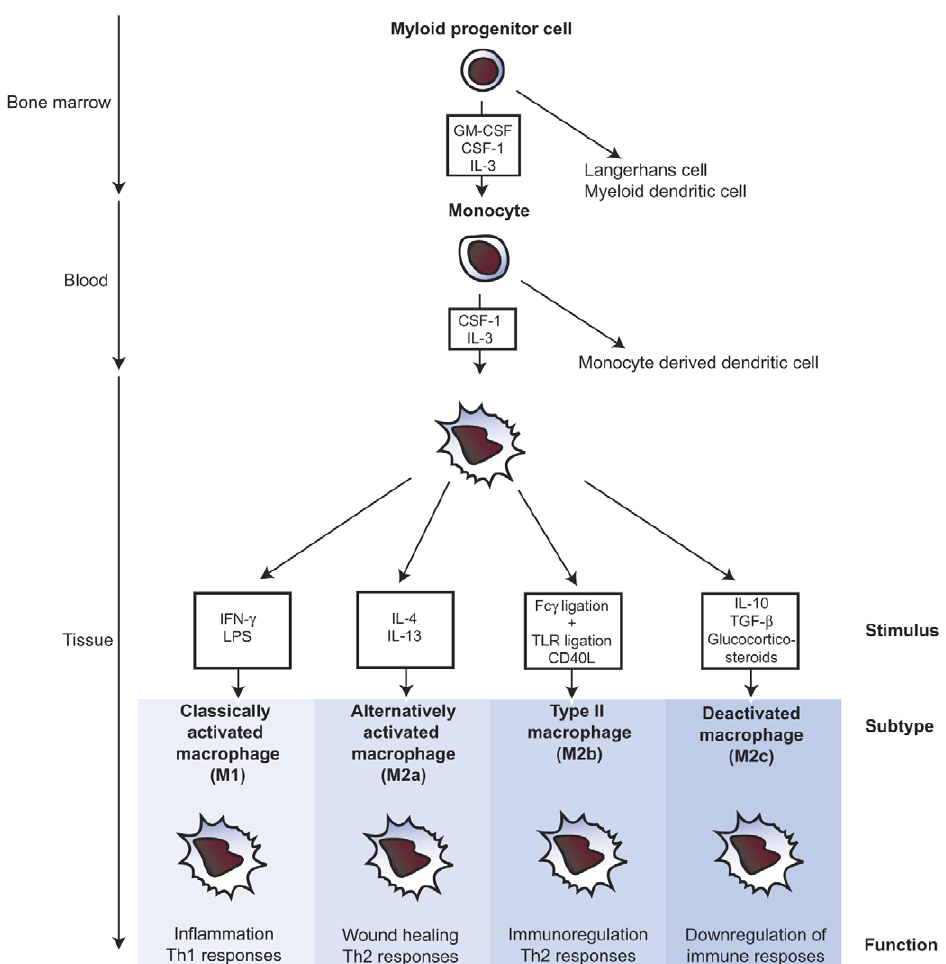
Fig. 1. Origin and activation of macrophages. Myeloid progenitor cells undergo differentiation into monocytes/macrophages after stimulation with GM-CSF, CSF-1 and IL-3. The presence of diverse environmental stimuli leads to differentiation into different macrophage subsets with dissimilar functional